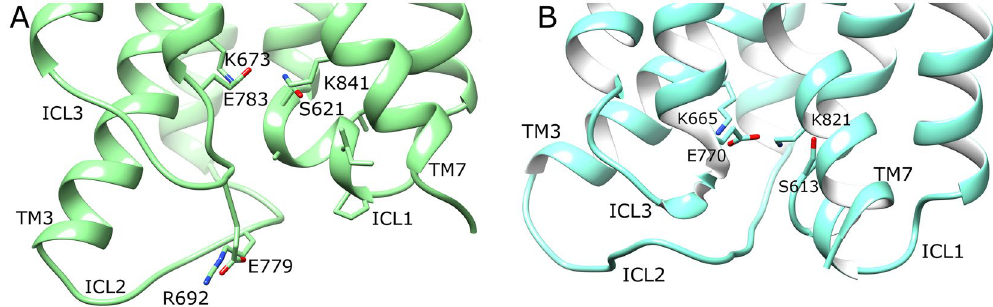
Figure 3. Average conformations of intracellular loops and selected charged/polar residues of ( A ) apo mGlu4 (green) and ( B ) apo mGlu5 (cyan), obtained from 2.5–5 µ s of respective MD simulations. Relevant structural features are labelled, i.e. intracellular loops (ICLs) and intramolecular locks, i.e. K673-E783 in mGlu4 ionic-lock and K665-E770 in mGlu5 ionic-lock.